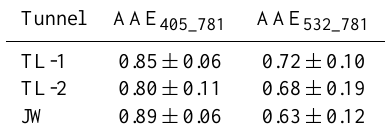
AAE BC values derived from the ambient measurements in urban Shenzhen.